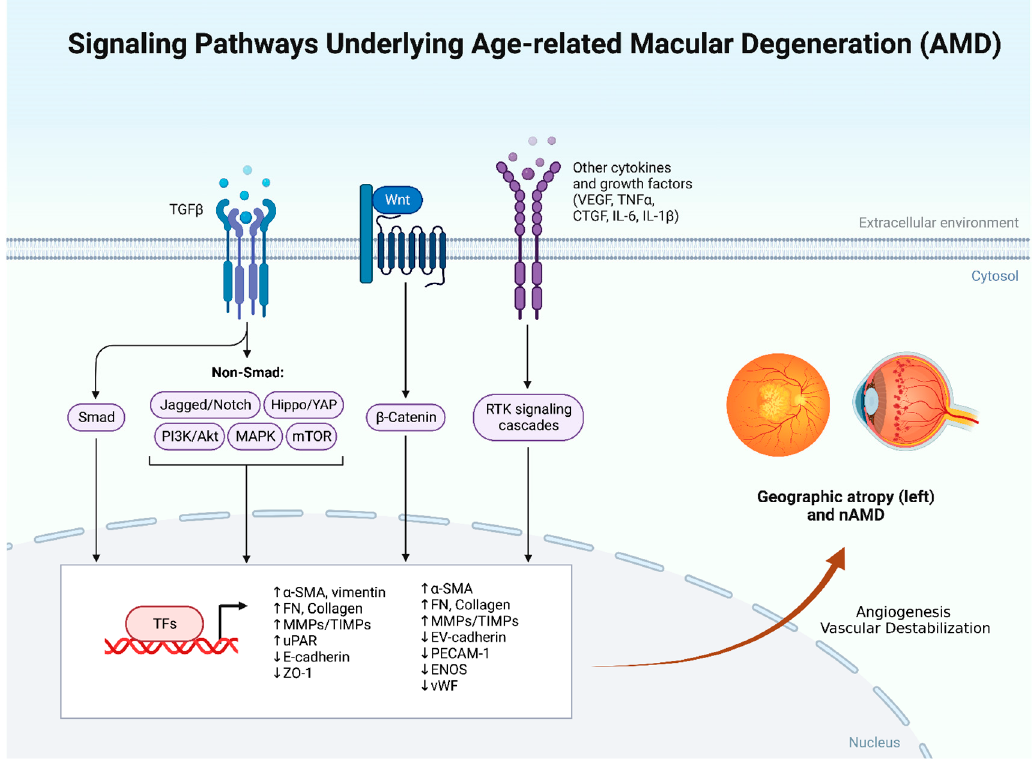
Figure 1 . Summary of the pathophysiologic mechanisms involved in the development of age-related macular degeneration.